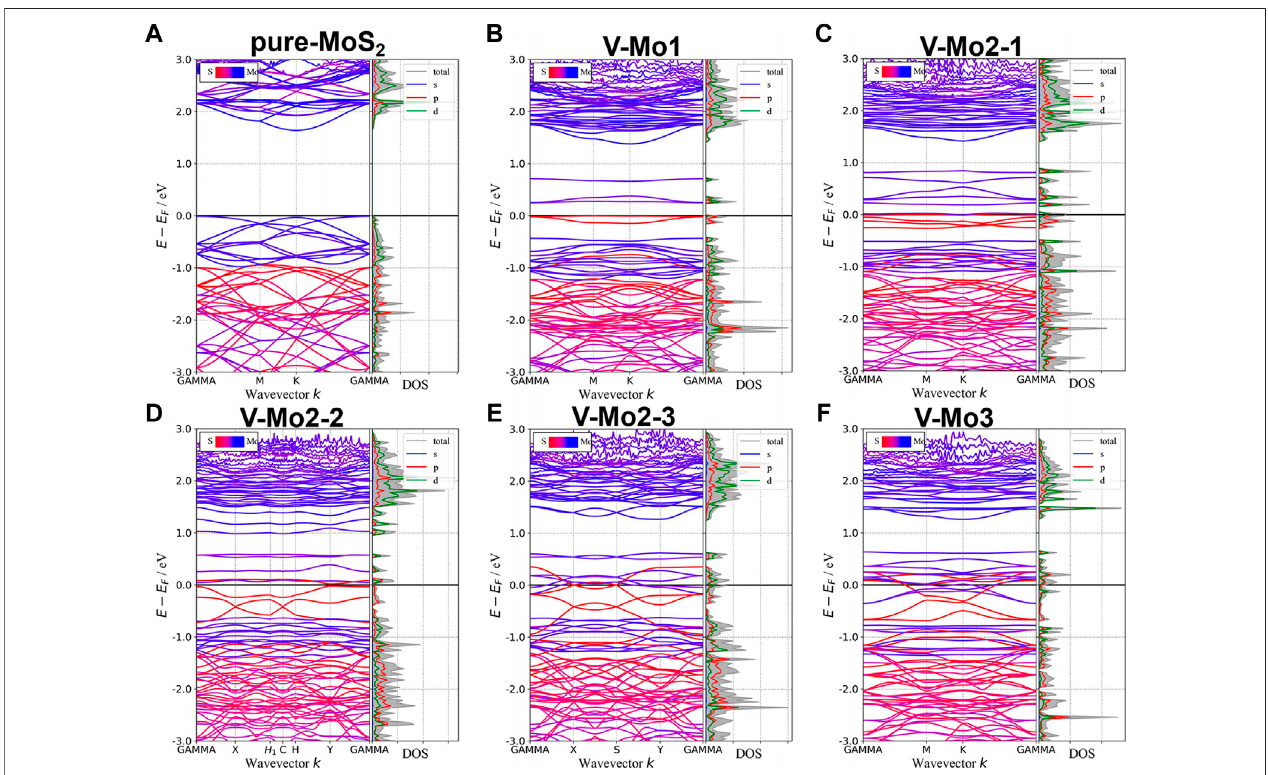
FIGURE 8 | Band structures and pDOS of monolayer 2H-MoS 2 with different Mo-vacancy defects. The labels of different vacancy structures are denoted above each fi gure. The corresponding atomic con fi gurations can be referred to Figure 7 .